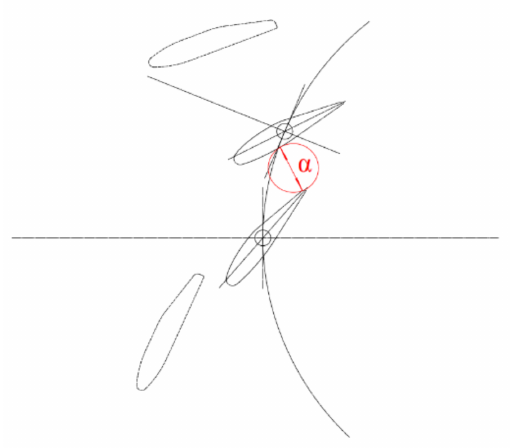
Figure 5. Physical meaning of α